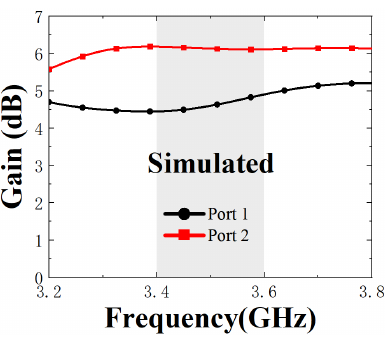
Figure 10. Gain of the proposed